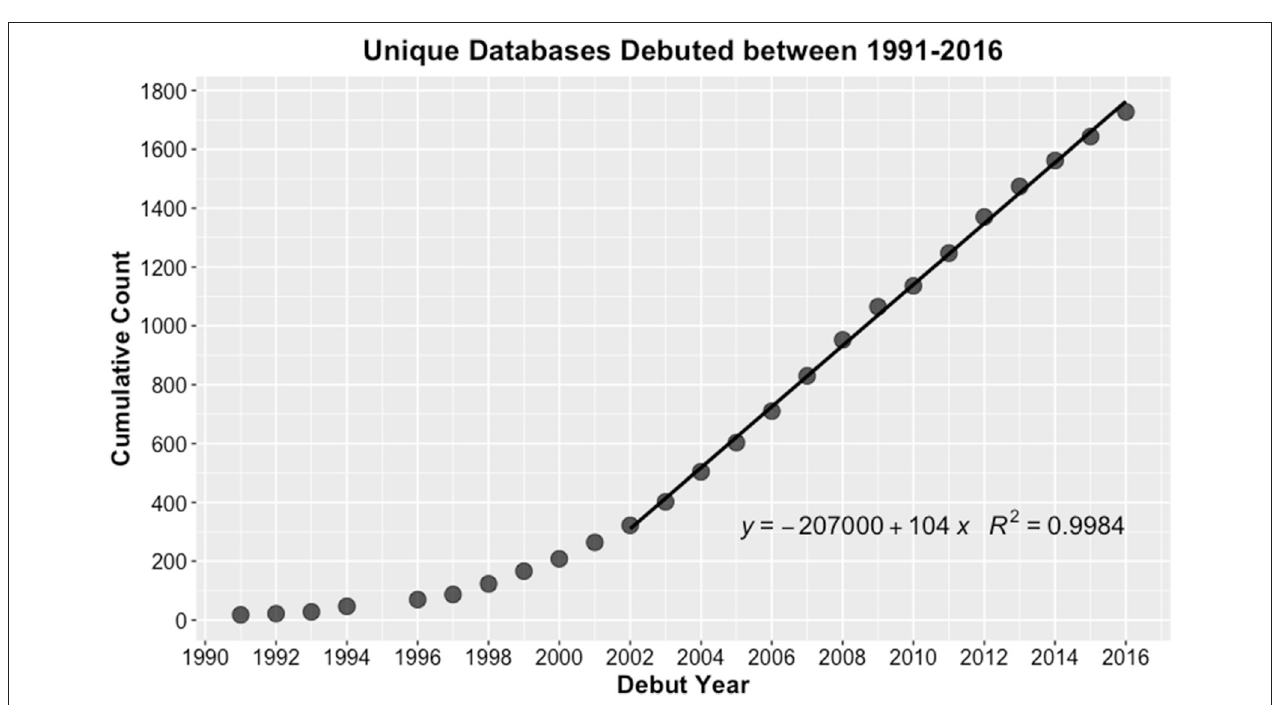
FIGURE 2 | The accumulation of unique databases debuted in NAR Database Issues between 1991 and 2016 shows a continual trend of increased growth overall and linear proliferation in recent years, with maximum curvature in 2002.